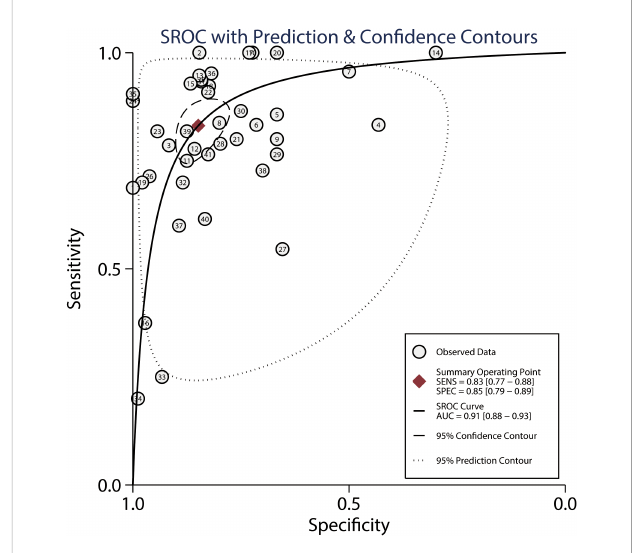
FIGURE 4 Summarized ROC curve and AUC for